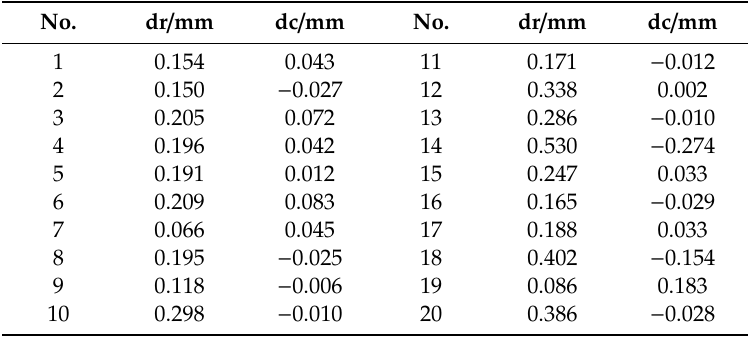
Table 2. Assembly deviation prediction by least-squares